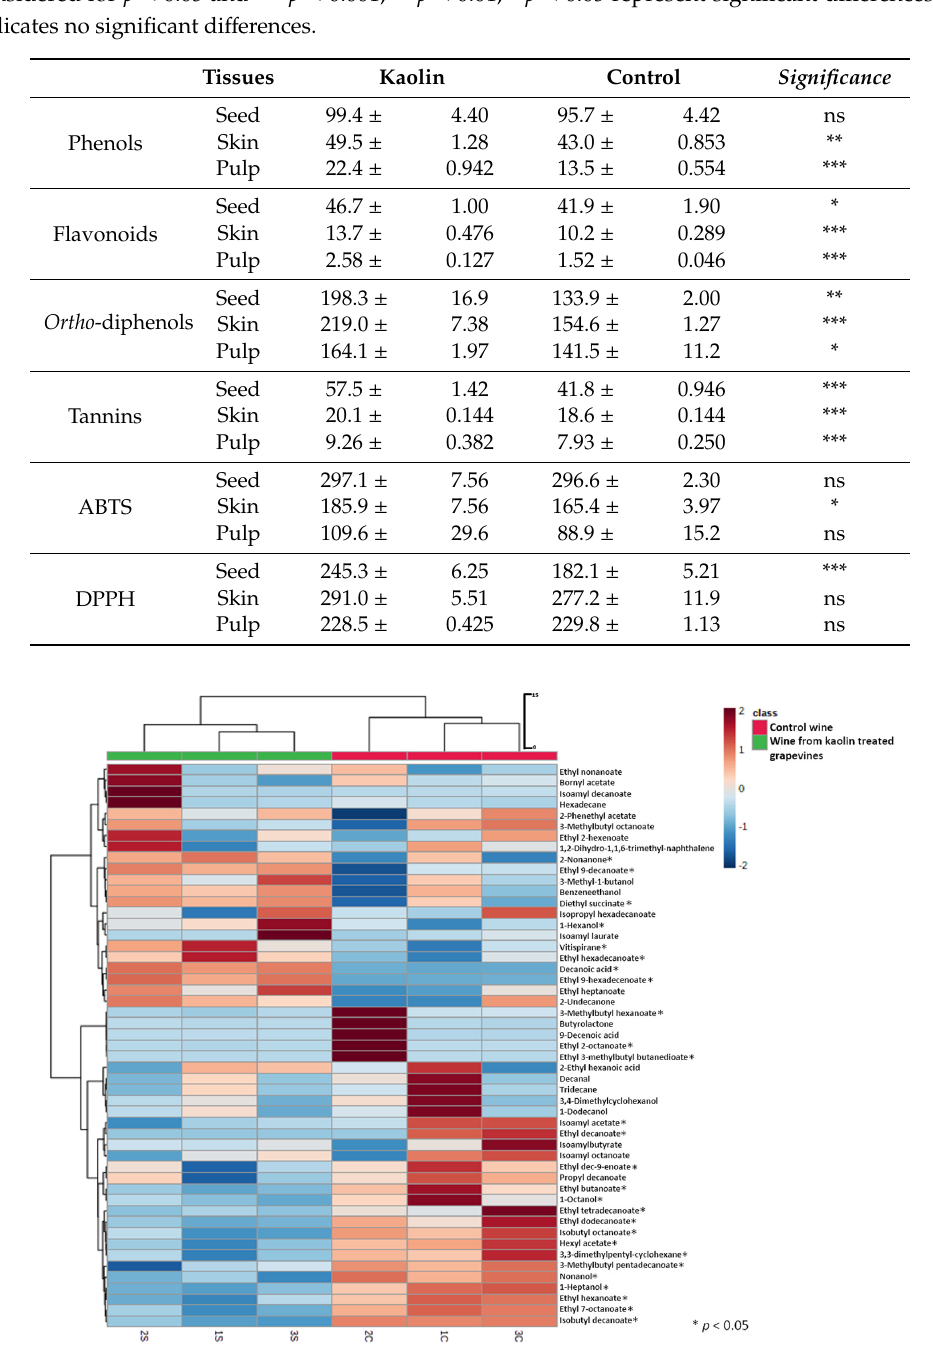
Figure 4. Heatmap and dendrogram representation of the 51 volatile components from ‘Cerceal’ cv.